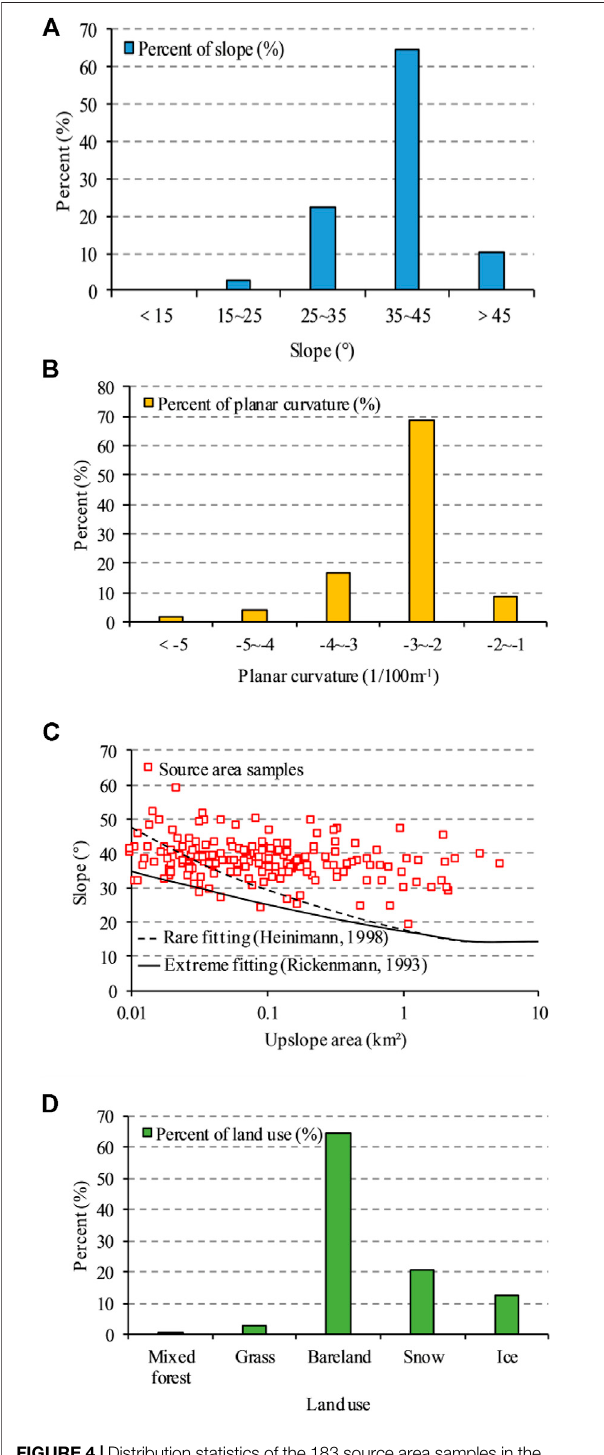
FIGURE 4 | Distribution statistics of the 183 source area samples in the study area. (A) Slope; (B) Planar curvature; (C) Slope and upslope area threshold curves, including rare fi tting (Heinimann, 1998), extreme fi tting (Rickenmann and Zimmermann, 1993), and the samples in the study area; (D) Land use. FIGURE 5 | Schematic diagram of the debris fl ow paths